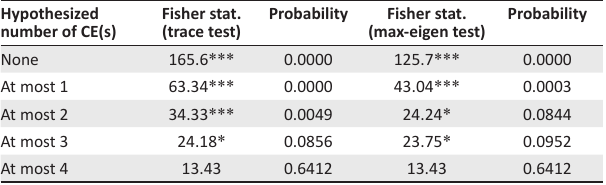
TABLE 4-A1: Johansen Fisher panel cointegration test with no deterministic trend test.